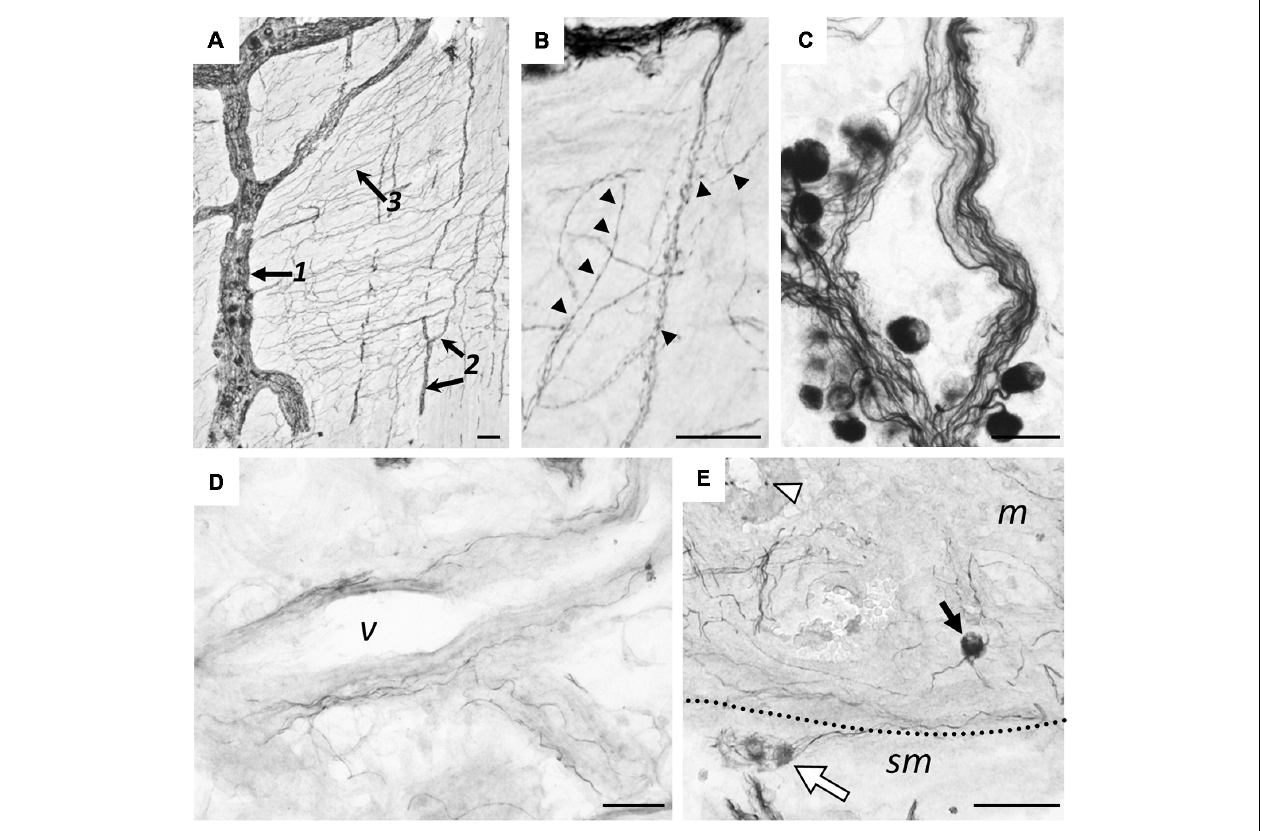
FIGURE 8 | Immunohistochemical staining using hpChAT antiserum in human ascending colon. Positive nerve fibers and cells in the myenteric plexus (A,B) , submucosa (C,D) and mucosa (E) . A section through the myenteric plexus (A) shows positive labeling in primary nerve strands (arrow 1), secondary nerve strands (arrows 2) and fine-meshed tertiary nerve network (arrow 3). At a high magnification of the tertiary network (B) , fine hpChAT-ir fibers appear to be varicose (arrowheads). In a section through the submucosal plexus, smooth or non-varicose fibers are located in nerve strands (C) . Occasionally, smooth positive fibers are seen to run along a blood vessel (v) in the submucosa (D) . Panel (E) shows two hpChAT-ir submucosal cells (white arrow) and a round positive cell (black arrow) in the mucosa (m) near the submucosa (sm). Bars = 50 µ